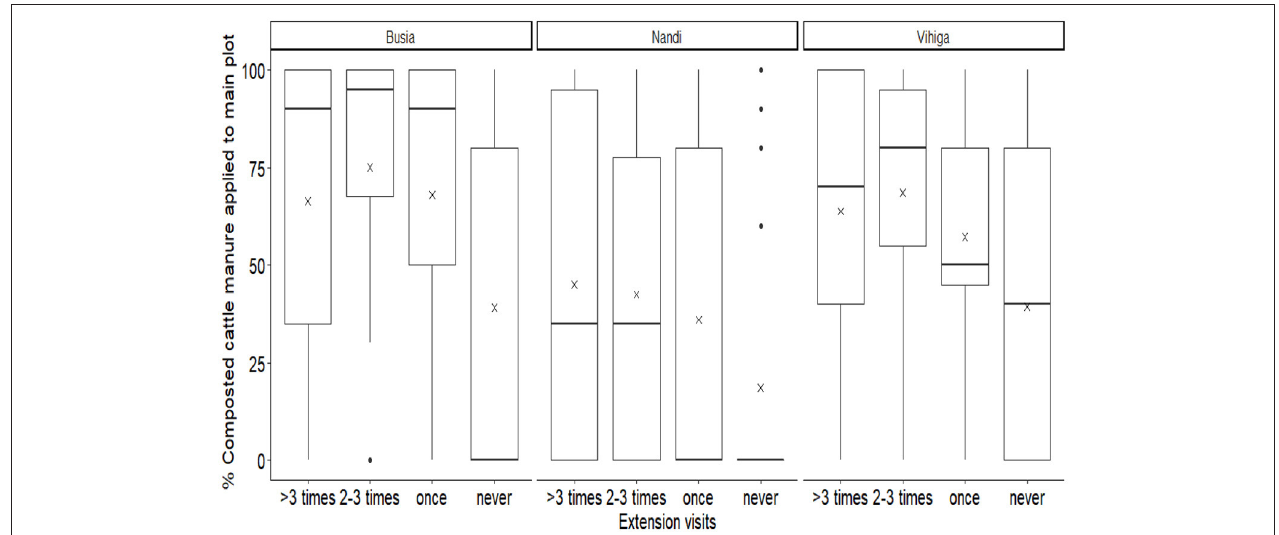
FIGURE 4 | The percentage of composted cattle manure applied in farmers’ main plot as influenced by the number of interactions with extension agents in Busia, Nandi, and Vihiga counties in western Kenya. Box plots show the spread the data points for each group, while the mid-line represents the median of each group and x indicates the group mean.